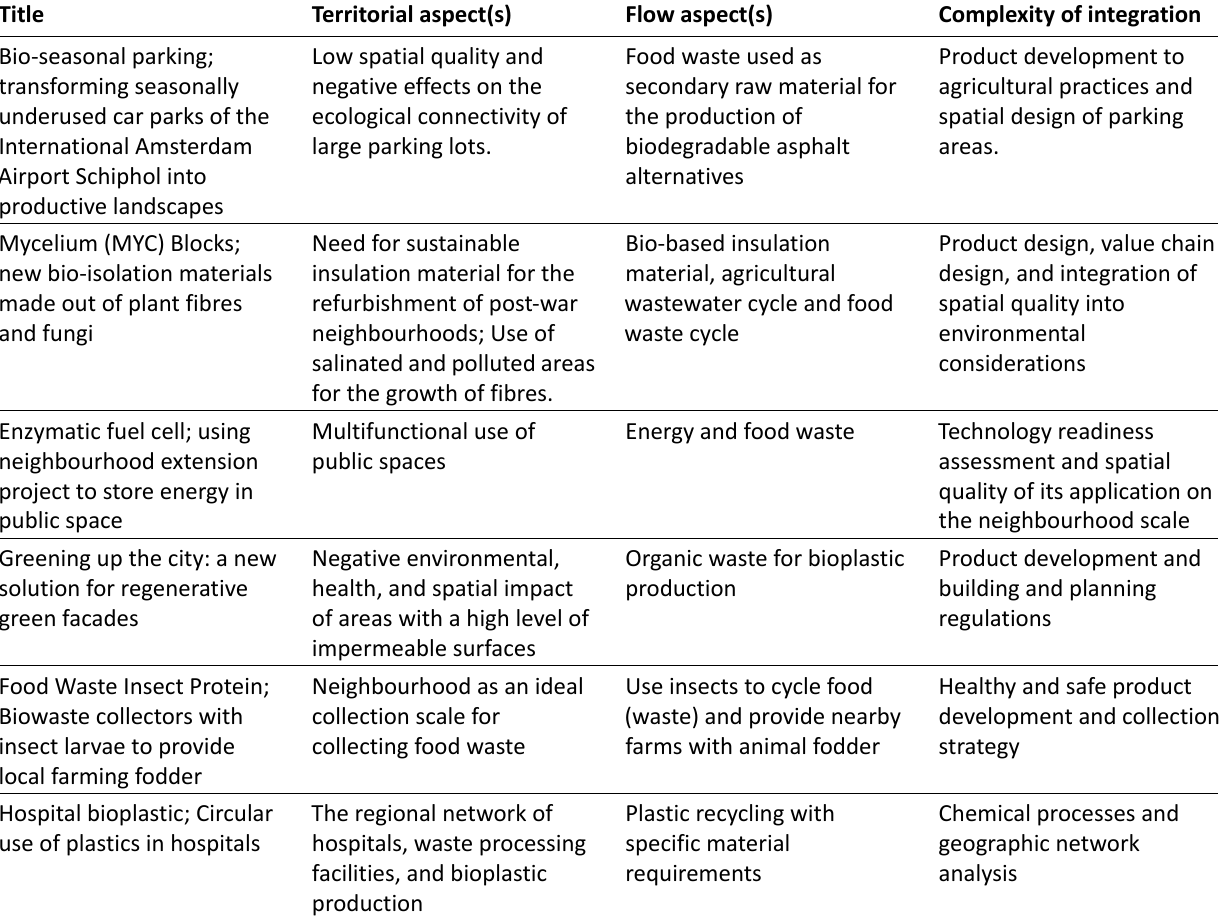
Table 2. EIS, their territorial and flow aspect, and the complexity of their